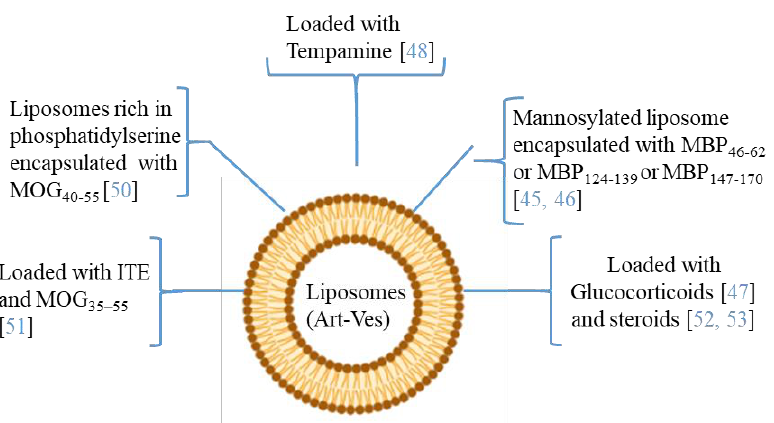
Figure 3 . The picture illustrates some researches in which the therapeutic potential of liposomes/ar- tificial vesicles loaded with different molecules, antioxidant, anti-inflammatory (immunosuppres- sive effect), myelin antigens (immunotolerance effect), or in combination, as a potential therapeutic approach in